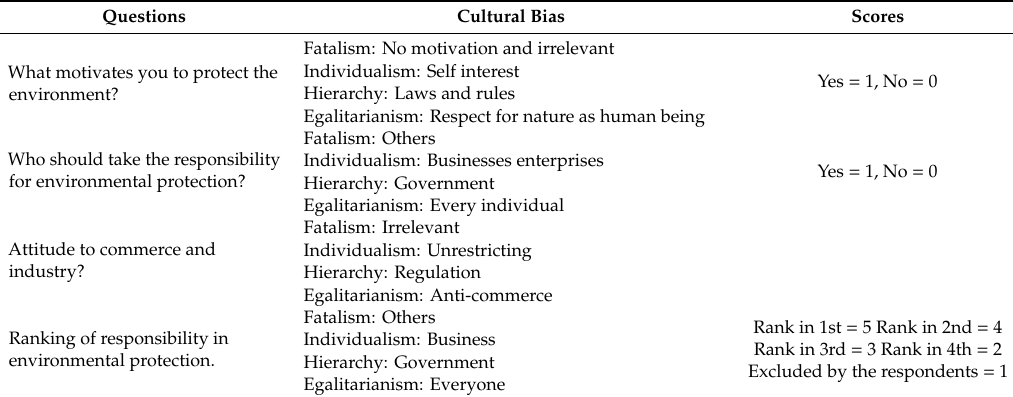
Table 2. Measuring